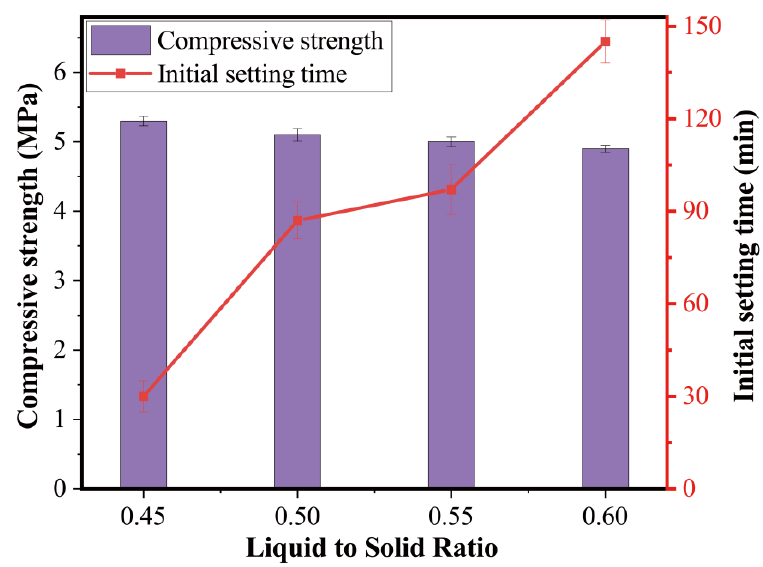
Figure 9. Influence of liquid – solid ratio on the paste.